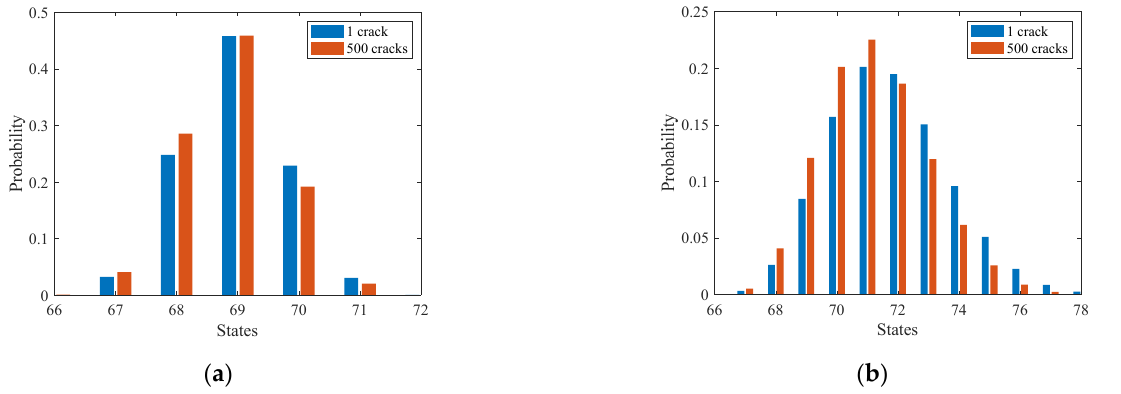
Figure 17. Comparison of posterior probability distributions of fatigue crack size considering the inspection data of only one crack and 500 cracks. ( a ) Fatigue crack size for current time step. ( b ) Fatigue crack size for future time step.